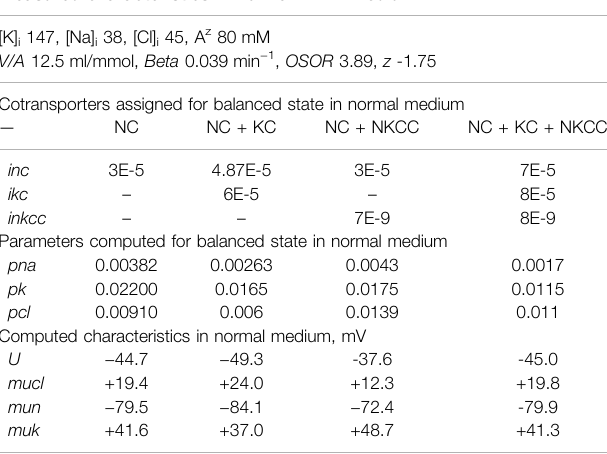
TABLE 2 | Basic characteristics of ion distribution, measured in living U937 cells equilibrated with a normal isotonic medium RPMI, and computed for models with different sets of parameters.